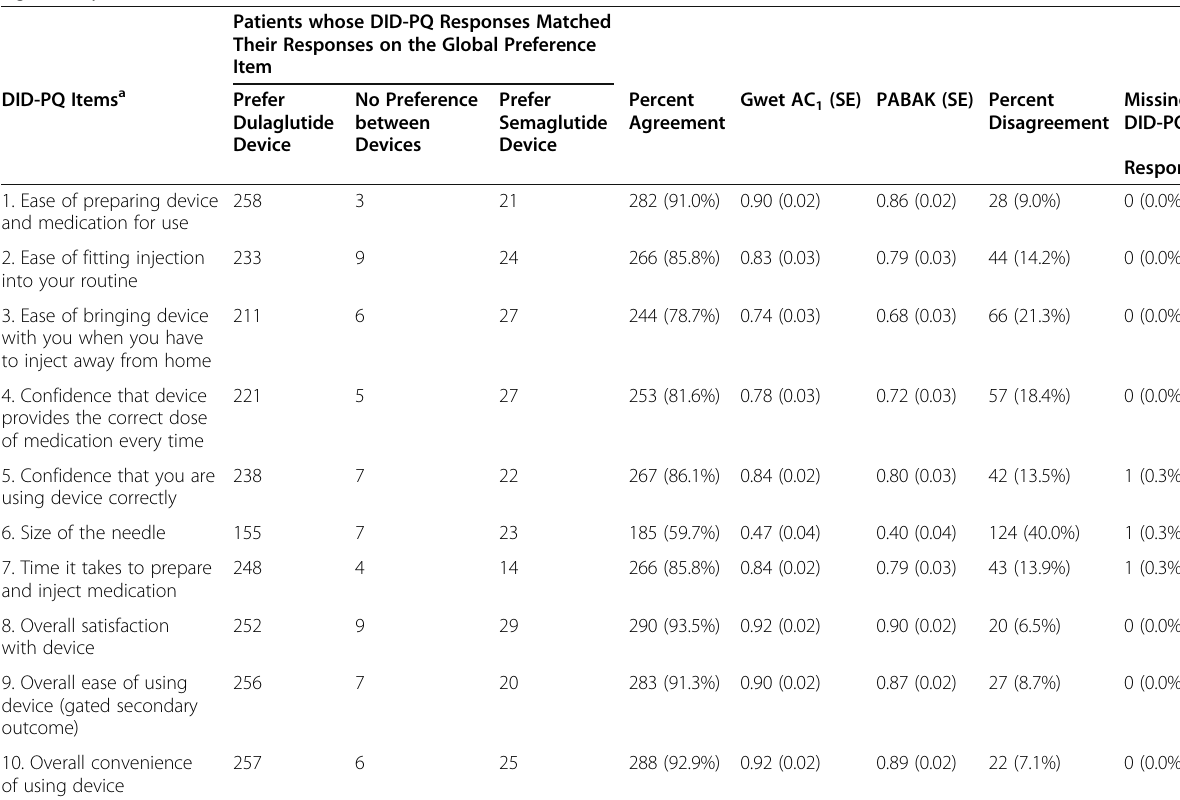
Table 2 Agreement Between DID-PQ Items and the Global Preference Item Assessing Preferences between Two GLP-1 Receptor Agonist Injection Devices ( N =